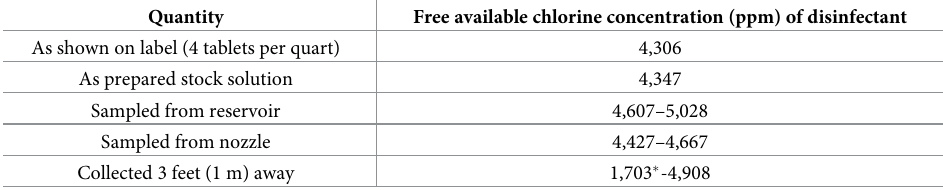
Table 6. Fate of active ingredient when spraying a dichlor-based